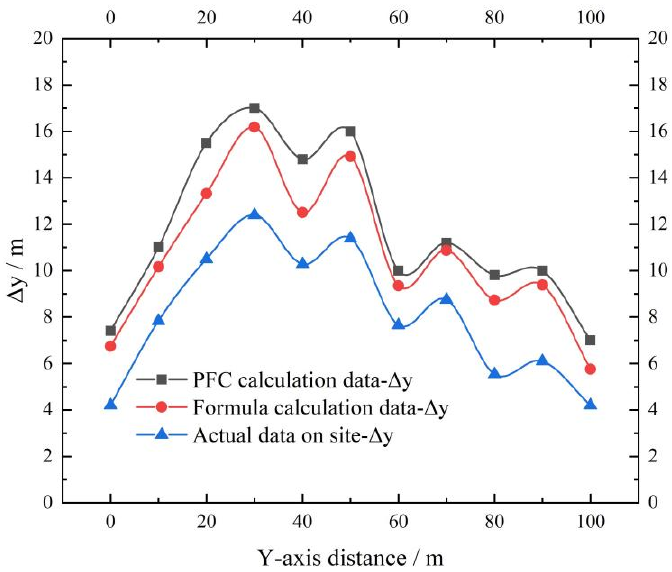
Figure 13. Comparison diagram of scouring depth curves.